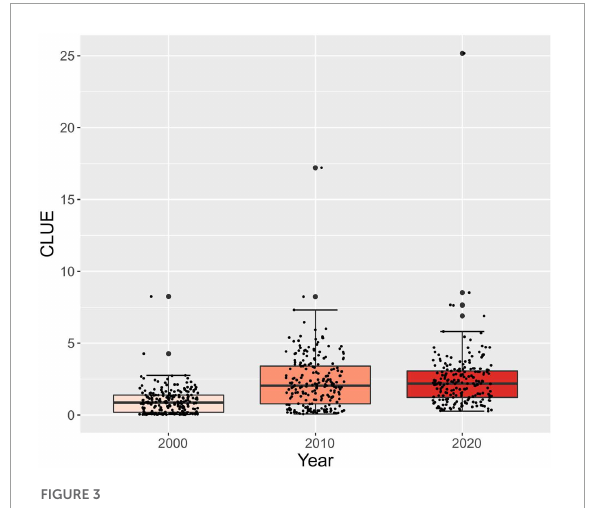
FIGURE3 Boxplot of the changing trends of CLUE (million RMB per hectare) in the YRD in 2000, 2010, and